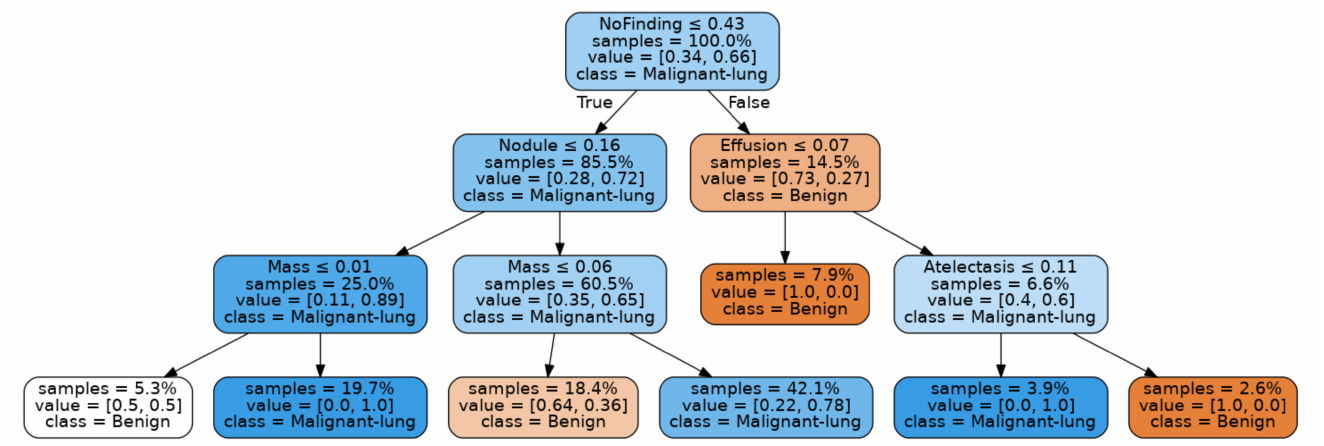
Figure 10. Decision tree fitting best result from LIDC-IDRI Images.